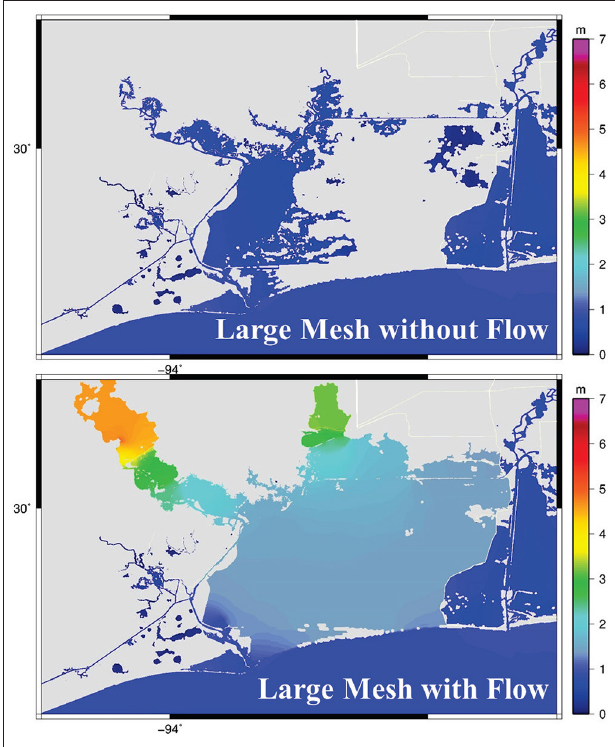
FIGURE 5 | Maximum elevation in the computational elements over the period of simulation for the large ADCIRC mesh with and without riverine flow